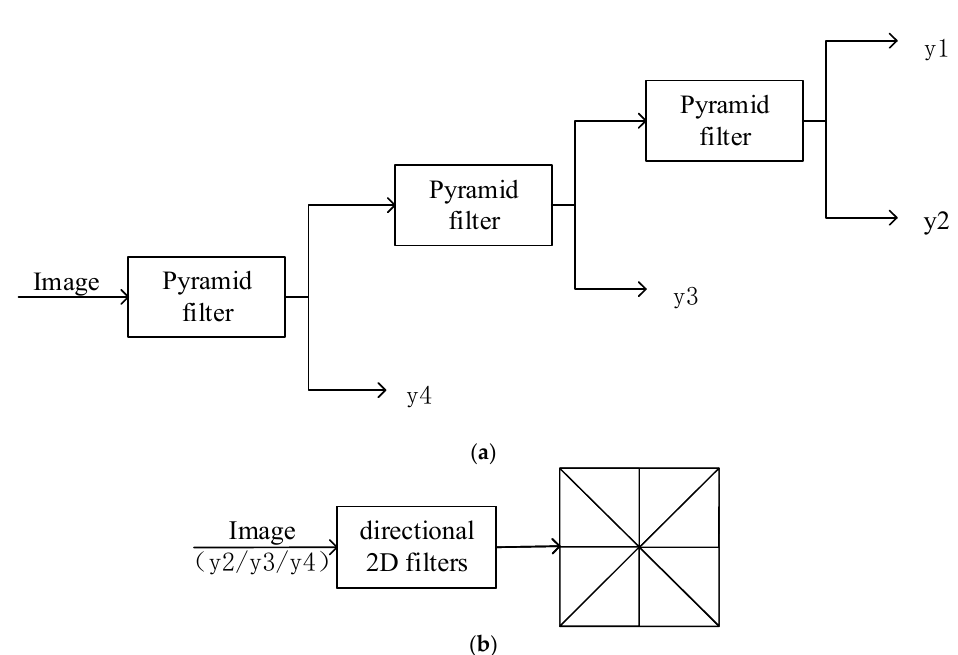
Figure 5. The two parts of the nonsubsampled contourlet transform (NSCT) for the decomposition diagram . ( a ) Nonsubsampled pyramid filter bank (NSPFB) decomposition diagram with the pyramid filter (y1 is the final obtained low-frequency sub-band) . ( b ) Nonsubsampled directional filter bank (NSDFB) decomposition diagram with the directional 2D filters (decomposition of high-frequency images).